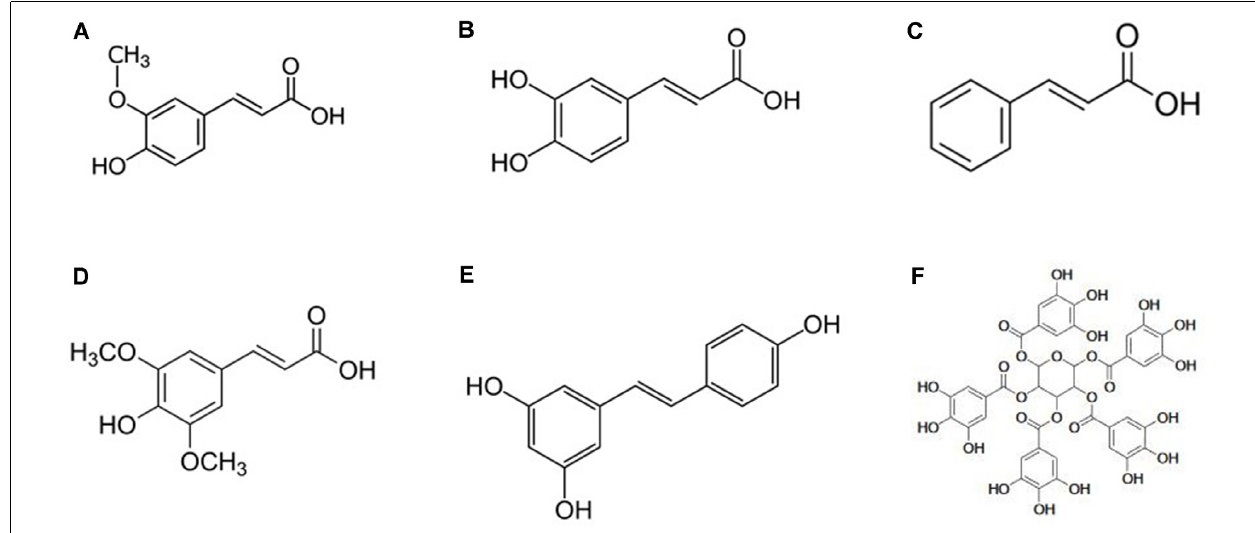
FIGURE 7 | Chemical structure of important non-flavonoids of sorghum with anti-AD activities (Lakey-Beitia et al., 2015; Girard and Awika, 2018; Jabir et al., 2018; A : ferulic acid, B : caffeic acid, C : cinnamic acid, D : sinapic acid, E : resveratrol, and F :